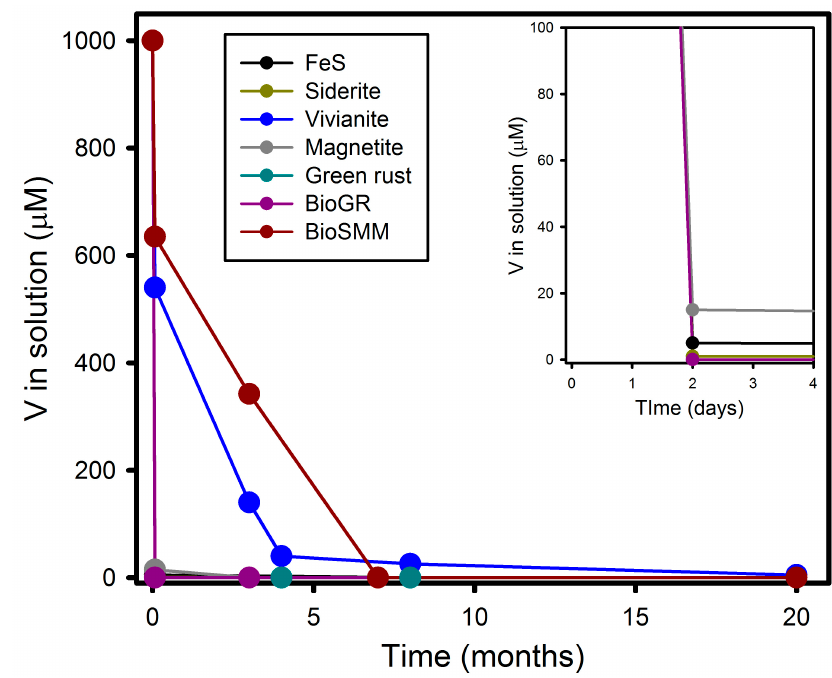
Figure 1. Solution phase V concentrations in the experimental systems over time. The lines are a visual aid only.